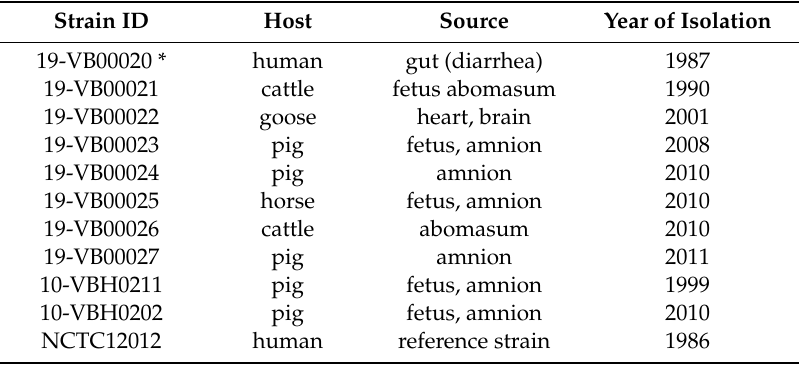
Table 1. V. cincinnatiensis strains used in this